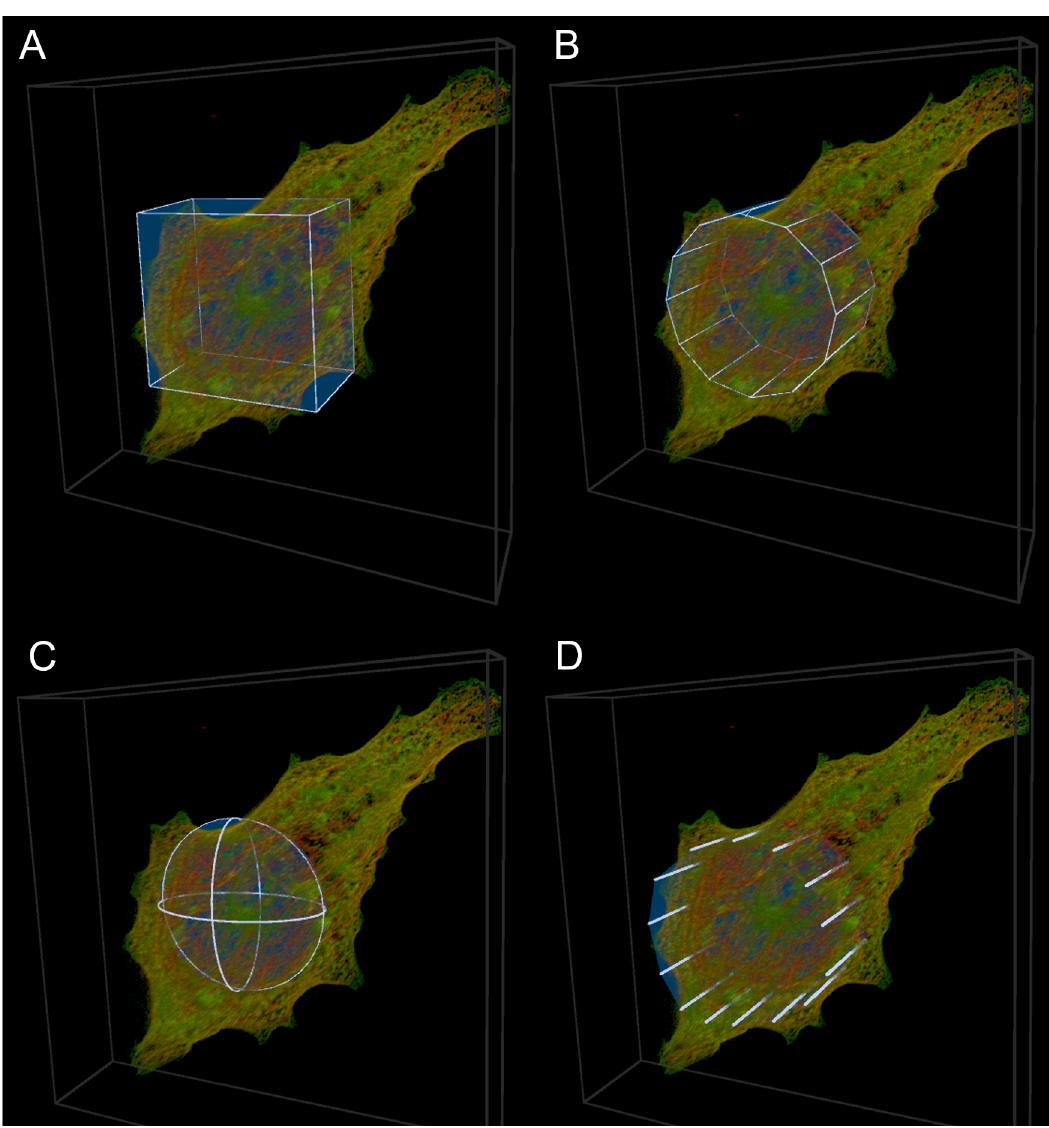
Fig 2. ROI selection tools. The ROI selection tools employed in the analysis. Combinations of these tools were used to make selections. A: The box tool. B: The cylinder tool. C: The sphere tool. D: The freehand tool.